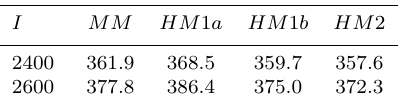
Table 2. Comparison of homogenized mathematical models: maximal values of temperature in K for the benchmark model MM and different homogenized models HM . Here I denotes the value of basic electrical current in